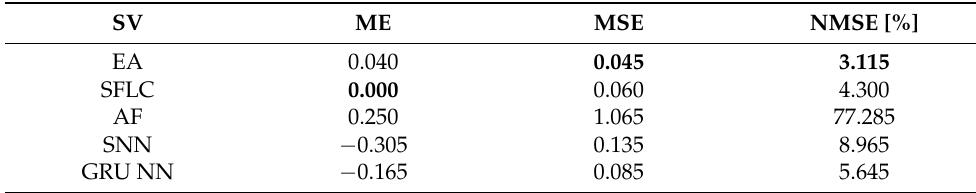
Table 4. SV results for ergometry tests.